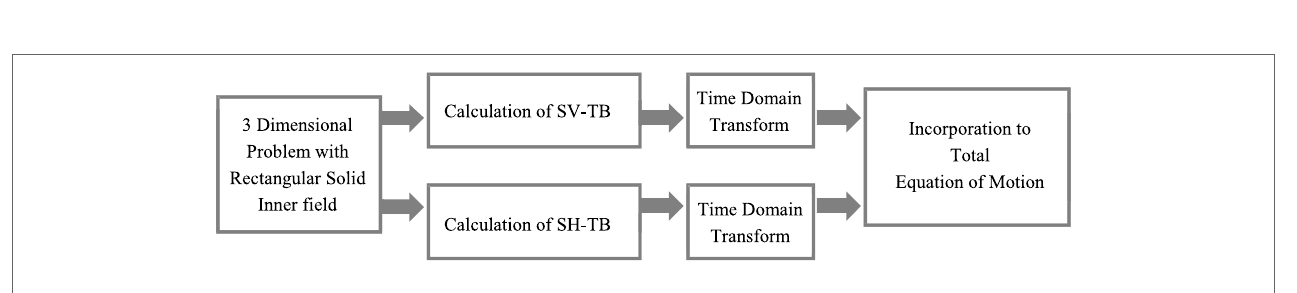
FigUre 4 | analysis flow